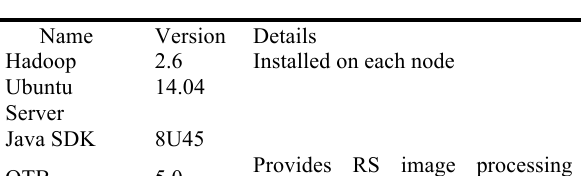
Figure 2. Time consumption for PC and cluster with different image